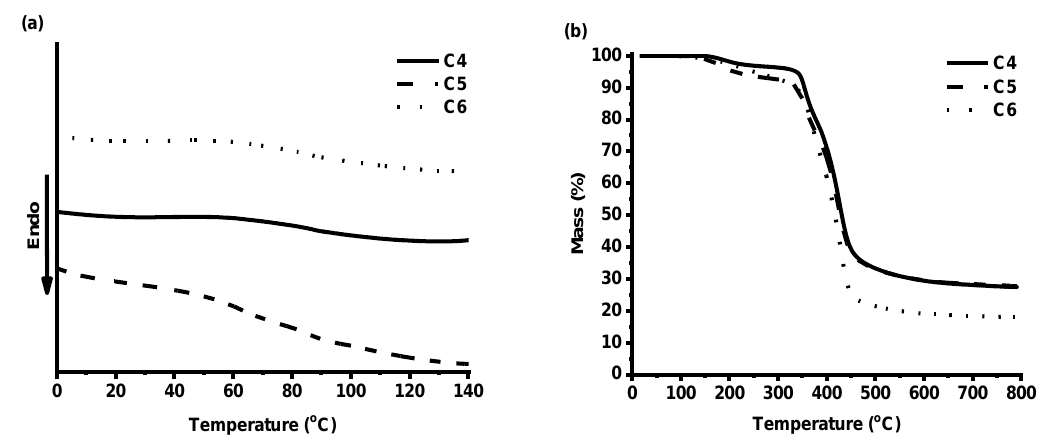
Figure 7. DSC thermograms ( a ) and thermogravimetric curves ( b ) of cross-linked polymers C4 –